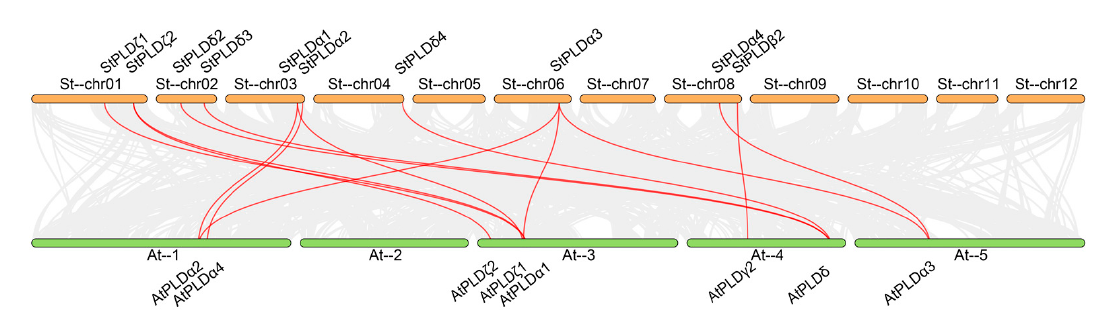
Figure 7. Homology analysis of PLD genes between potato and Arabidopsis. Gray lines: Collinear blocks between potato and Arabidopsis genomes. Red lines: Syntenic PLD gene pairs between potato and Arabidopsis.